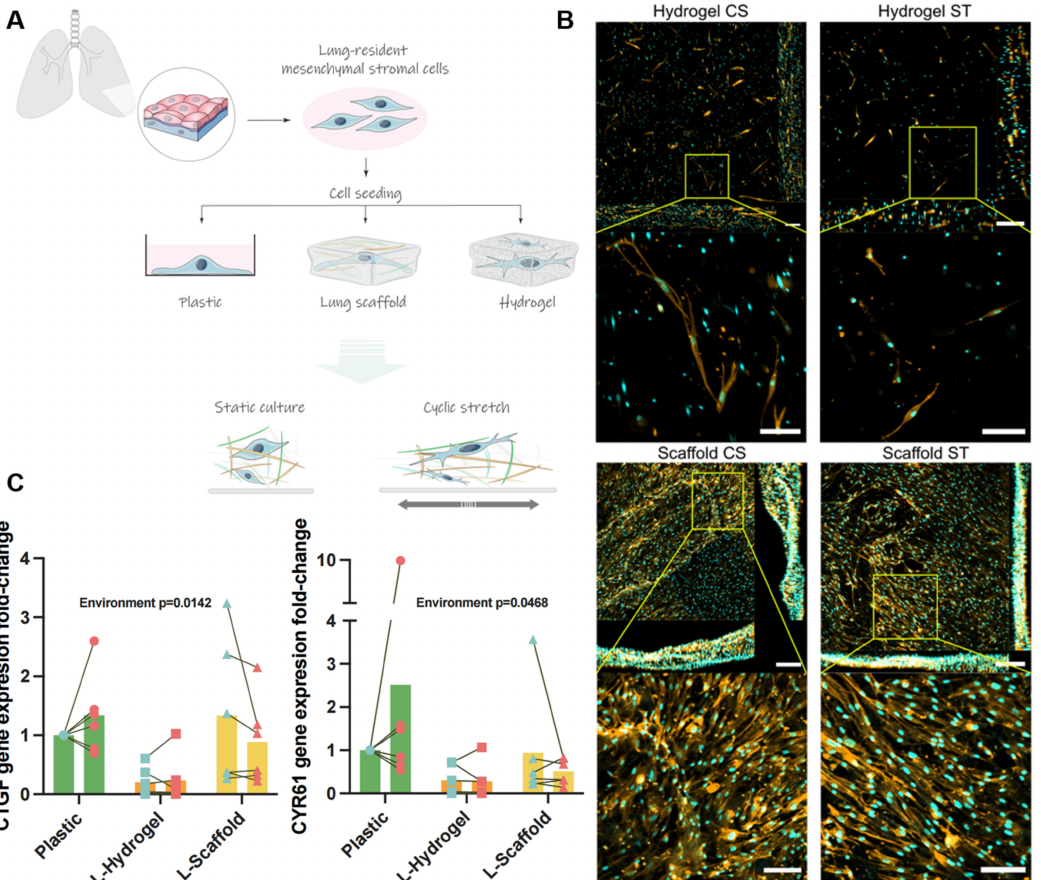
Figure 1. ( A ) Workflow to achieve physiomimetic culture of hLMSCs with mechanical cues from the lung; ( B ) 3D images of the physiomimetic culture of hLMSCs. Left side of the image is a 2D representation of the stack captured. In addition, a close-up image is attached showing the cell morphology and dispersion within the biomaterial. ( C ) Gene expression of CTGF and CYR61 expressed in fold changes compared to the plastic ST